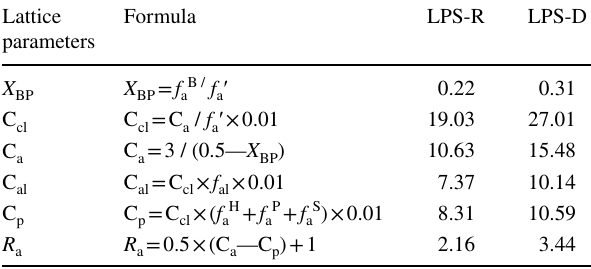
Table 6 Lattice parameters of LPS-R and